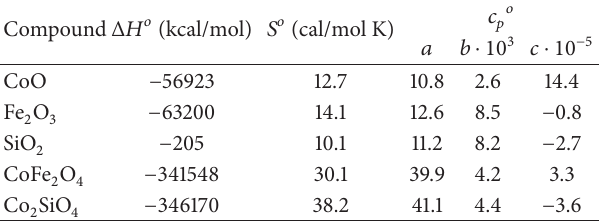
Table 2: Thermodynamic parameters of the compounds formed during